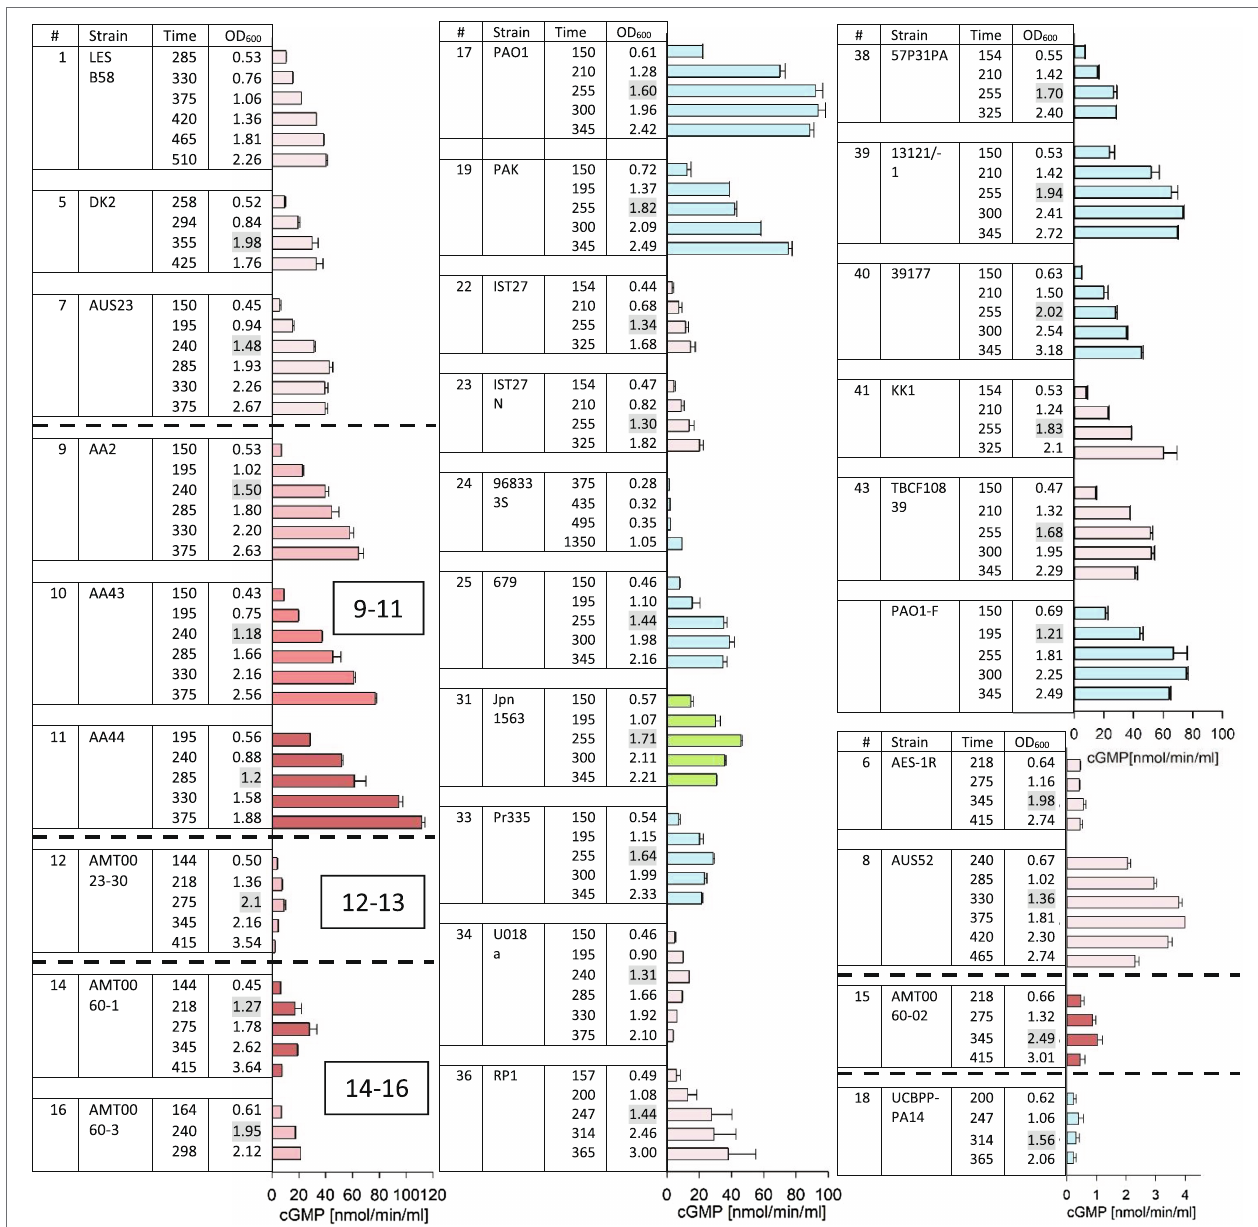
FIGURE 2 | ExoY prevalence in a subset of strains from the international P. aeruginosa panel. GC activity was measured as described in Material and Methods in bacterial culture supernatants induced for T3SS expression with addition of EGTA. Strains that were predicted to lack ExoY activity due to frameshift P242 as described in Supplementary Figure 1 (#13, 26, 29, 30, 32, and 42) and strains that had activities below 0.2 nmol/min/ml (#2, 3, 4, 20, 27, and 37) are not shown here. Cultures were inoculated (at an OD 600 of 0.05) into LB supplemented with 5 mM EGTA and 20 mM MgCl 2 to induce the T3SS. We started to collect 1 ml aliquots for activity assays during the exponential growth phase starting from an OD 600 of 0.5 and continued after bacteria had entered the stationary phase of growth. Elapsed period of time (min) since the start of cultures and OD 600 of the collected samples are indicated in the table. OD 600 values highlighted in grey indicate first samples that were taken after cultures had entered the stationary growth phase. GC activities were measured using 15 μ l of bacterial culture supernatant and correspond to averages of at least two measurements. Error bars indicate SD. Pink bars represent samples from cystic fibrosis ( CF ) isolates with darker shades corresponding to later isolates within a set of sequential isolates from the same patient. Blue bars represent non- CF isolates of clinical origin. Green represents the only environmental isolate among the strains with activities of ≥ 1 nmol